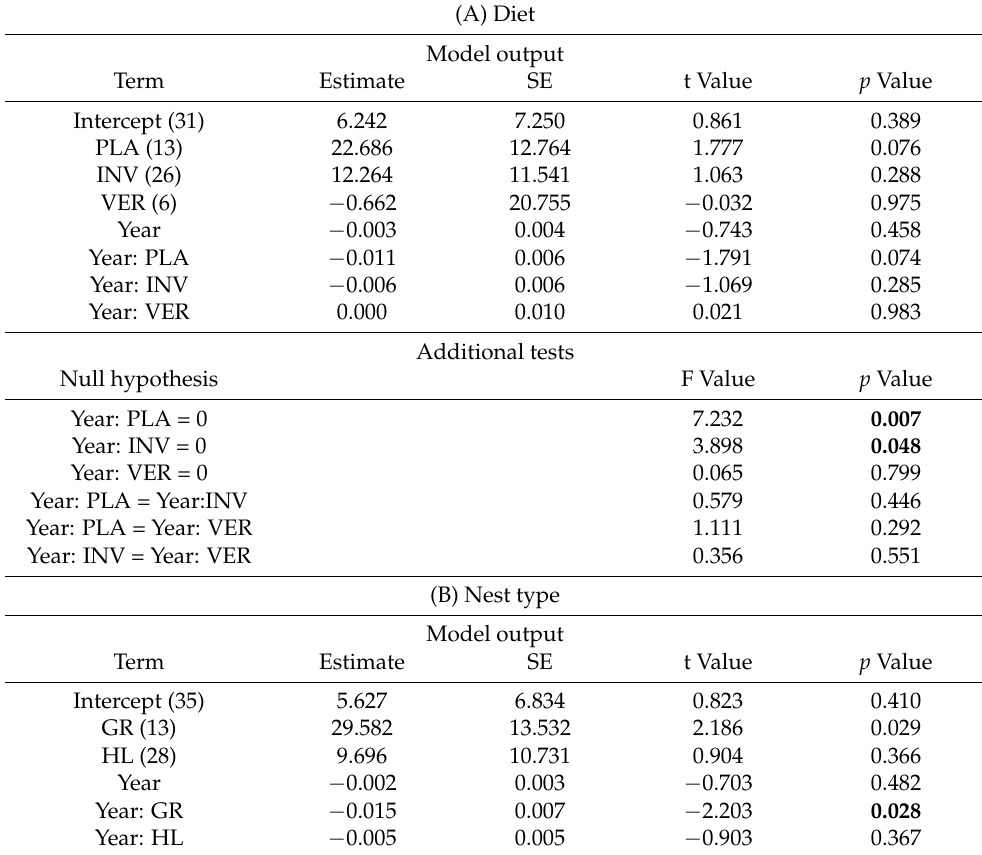
Table 3. Weighted linear regression models showing the response of avian functional groups in relation to ecological traits. In “model output” are shown model statistics (Estimate, estimated coefficient; SE, standard error; t value, t-statistic) and the significance of each coefficient ( p value). The term “Intercept” and “Year” represent the reference group. The number of species included in each group is shown in parentheses. In “Additional tests” are shown tests of equivalence to zero of interaction effect of non-reference levels and tests of equivalence between the interaction terms for the other levels (F value: F statistic). Significant p values ( ≤ 0.05) for the interaction terms are marked in bold. (A) Diet. Groups: omnivores (references level), plant-eaters (PLA), invertebrates (INV), vertebrates (VER); adj-R 2 = 0.01. (B) Nest type. Groups: elevated-nesters (reference level),